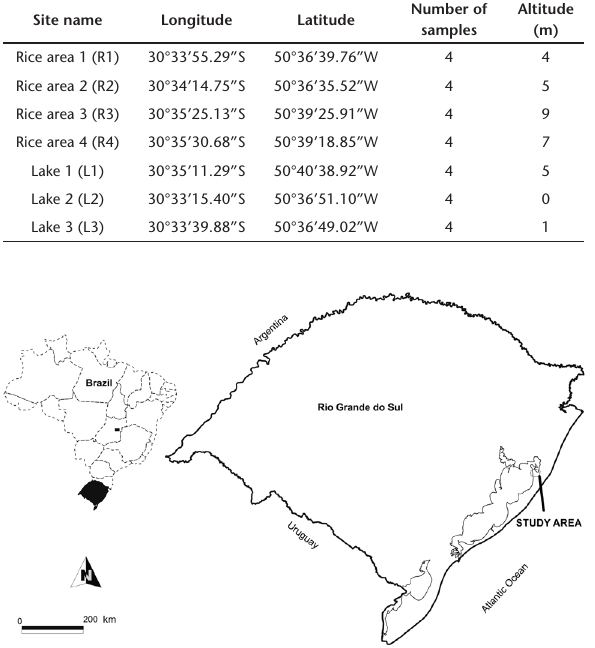
Figure 1. Schematic map of Brazil and Rio Grande do Sul State illustrating the study